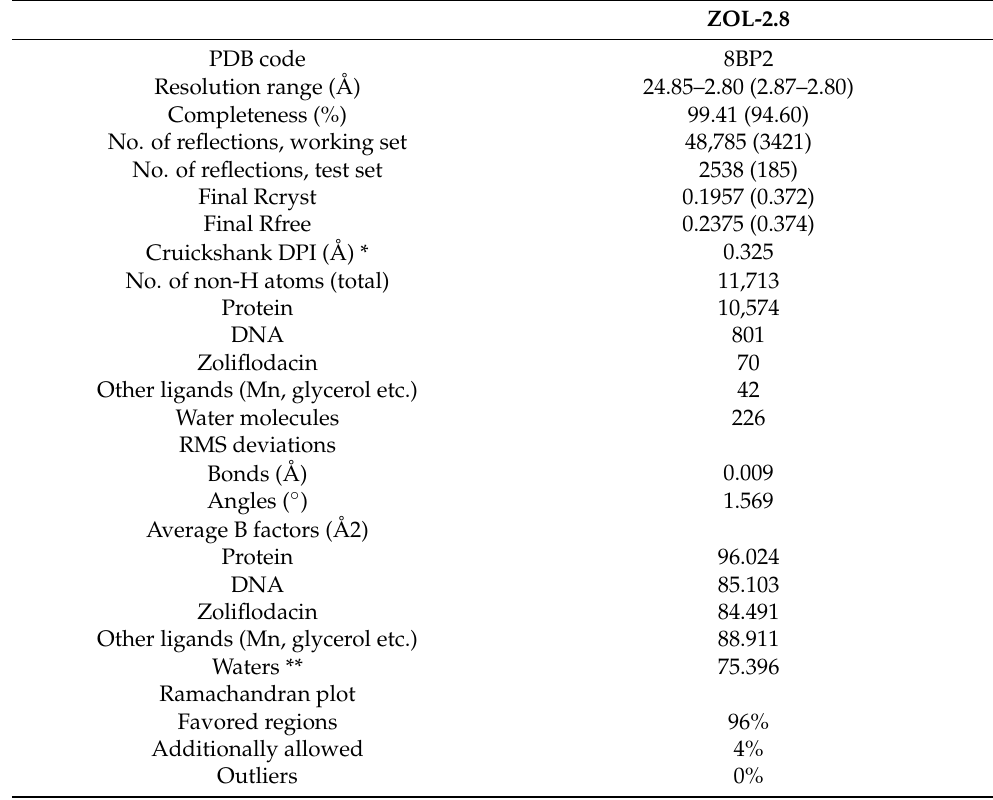
Table 3. Refinement